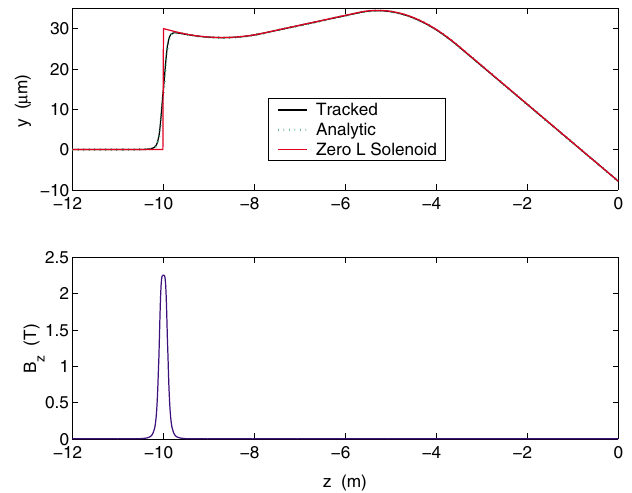
FIG. 9. (Color) Orbits with a short test solenoid of B‘ (cid:3) 0 : 5 T m placed on the detector axis at 10 m from the NLC IP. Orbits are obtained using particle tracking and analytical integration of the field for the exact model, and with a zero length approximation of the solenoid. IP is at z (cid:3) 0 m